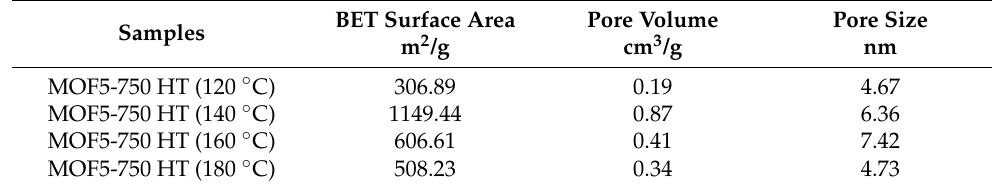
Table 1. Specific surface area, pore volume and pore size data of each sample.